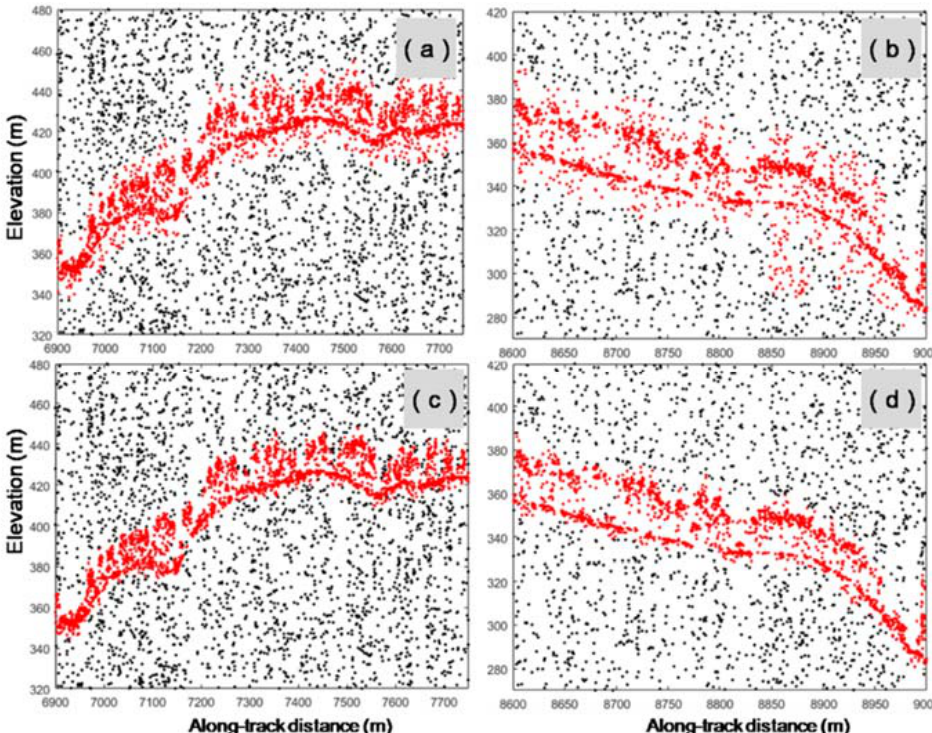
Figure 7. Partially enlarged views of test site A filtered by the LDS method ( a , b ) and the proposed method ( c , d ). Red dots represent signal photons; black dots represent noise photons.